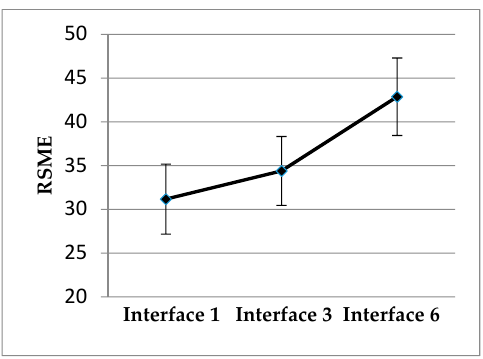
Figure 5. Mean and standard error of Rating Scale Mental Effort (RSME).